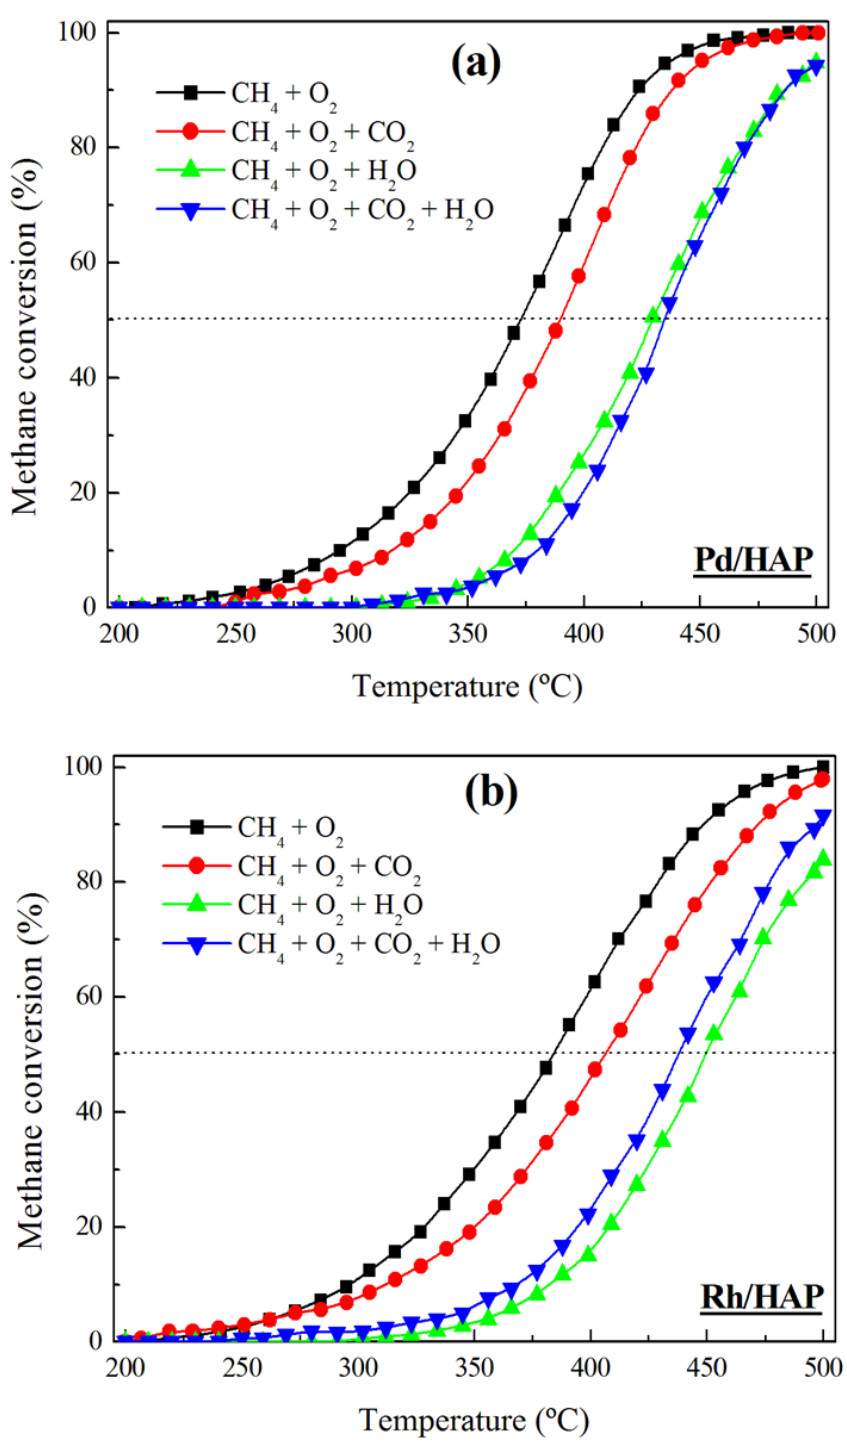
Figure 8. Influence of the reaction mixture composition on the performance of ( a ) Pd/HAP and ( b ) Rh/HAP catalysts in methane oxidation. Rh/HAP catalysts in methane